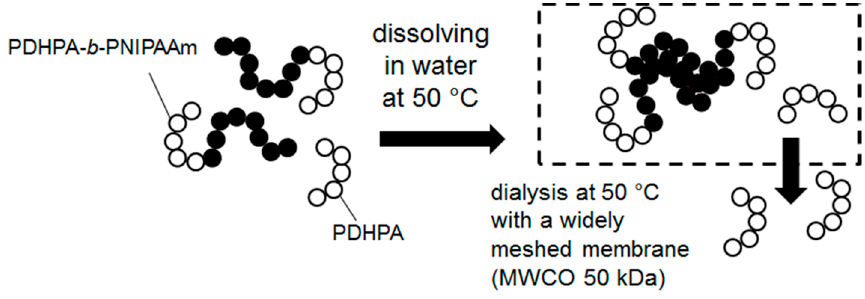
Figure 12. of residual poly(2,3-dihydroxypropyl acrylate (PDHPA) homopolymers by dialysis at 50 °C.